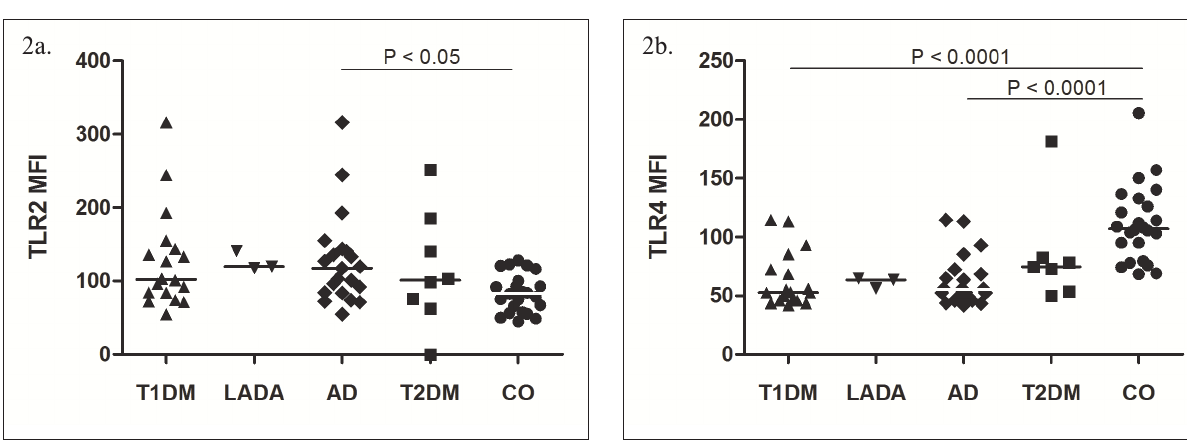
Fig. 2. Expression of TLR2 on CD14 + (a) and TLR4 on CD14 ++ (b) monocyte surface. TLR2 protein expression (a) is significantly increased on CD14 + monocytes from AD patients when compared to healthy controls; TLR4 antigen expression (b) is significantly lower on the CD14 ++ monocyte surface from T1DM and AD patients in comparison to healthy individuals. Horizontal bars represent group medians. T1DM, type 1 diabetes mellitus (N = 18); LADA, latent autoim- mune diabetes in adults (N = 3); AD, pooled autoimmune diabetes (N = 21); T2DM, type 2 diabetes mellitus (N = 8); CO, healthy control group (N = 24); MFI, mean fluorescent intensity.